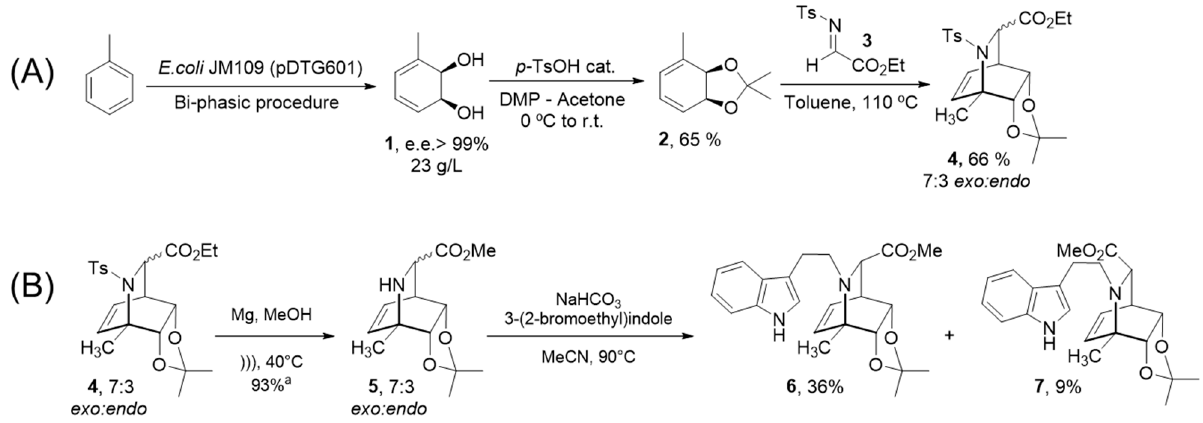
Figure 2. ( A ) Chemoenzymatic synthesis of the isoquinuclidine core 4 using toluene as starting material. ( B ) Preparation of N -indolylethyl isoquinuclidines 6 and 7 . a Yield estimated by 1 H-NMR of the crude reaction using trichloroethylene as internal standard.